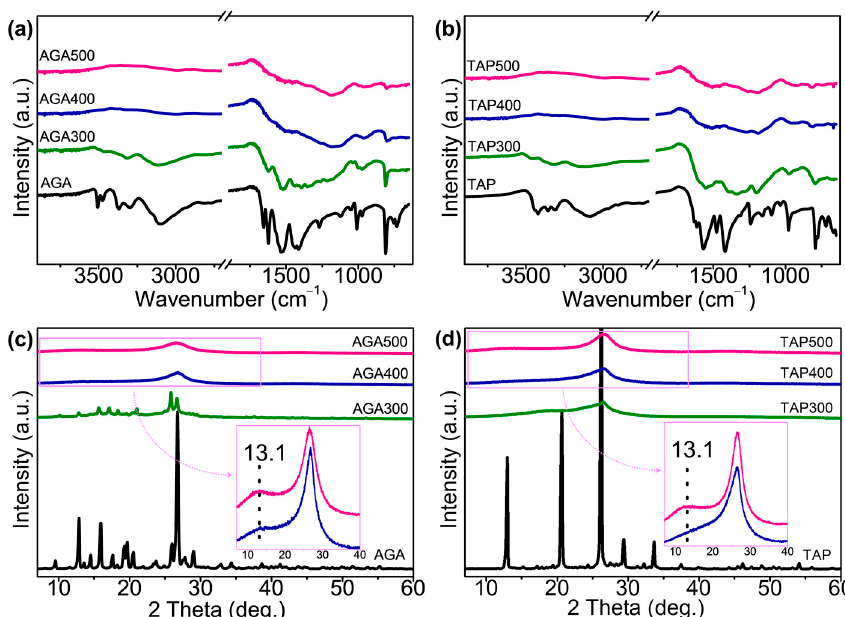
Figure 1. Fourier-transform infrared spectroscopy (FTIR) spectra of ( a ) acetoguanamine (AGA)- and Figure 1. Fourier ‐ transform infrared spectroscopy (FTIR) spectra of ( a ) acetoguanamine (AGA) ‐ ( b ) 2,4,6-triaminopyrimidine (TAP)-derived materials. X-ray diffraction analysis (XRD) patterns and ( b ) 2,4,6 ‐ triaminopyrimidine (TAP) ‐ derived materials. X ‐ ray diffraction analysis (XRD) pat ‐ terns of ( c ) AGA ‐ and ( d ) TAP ‐ derived materials. The inserts in ( c ) and ( d ) are enlarged views of of ( c ) AGA- and ( d ) TAP-derived materials. The inserts in ( c ) and ( d ) are enlarged views of the the corresponding area. corresponding